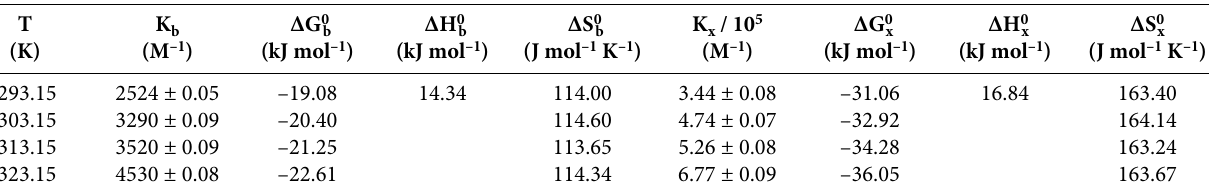
Table 1. Binding constant, partition coefficient and corresponding standard thermodynamic parameters for the interaction of quinizarin with SDS